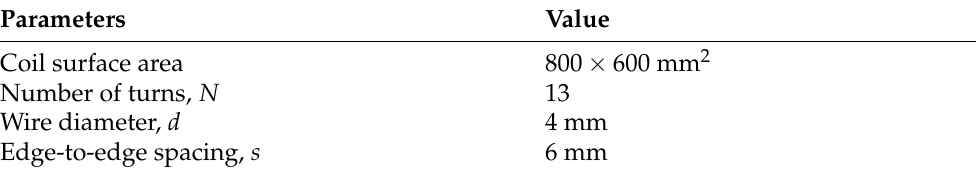
Table 2. Geometric specifications of the optimal DD coil